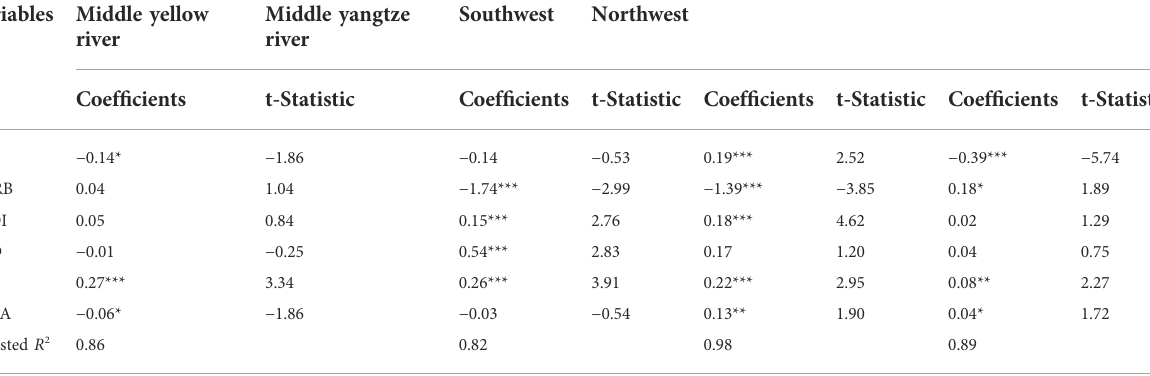
TABLE 7 Fixed effects model regression results